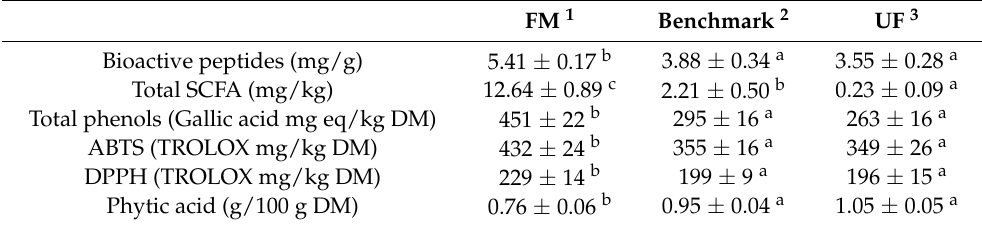
Table 7. Bioactive peptides, total SCFA, phenols, antioxidant activity (ABTS and DPPH) and phytic acid content in UF, benchmark and FM. Data represent means ± SD. For the same parameter, average values lacking a common letter ( a–c ) significantly differ from each